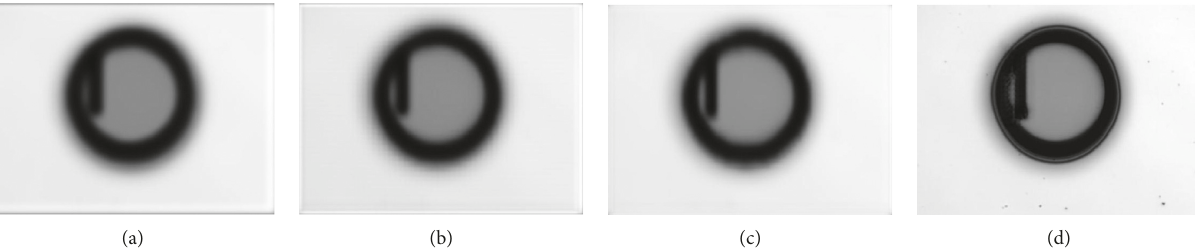
Figure 8: Change in abnormal PS according to training epoch. (a) 1 epoch. (b) 25 epochs. (c) 50 epochs. (d) 100